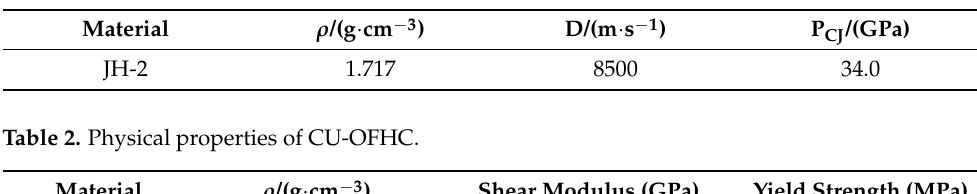
Figure 8. Established simulation model. Table 1. Physical properties of the JH-2 explosive.